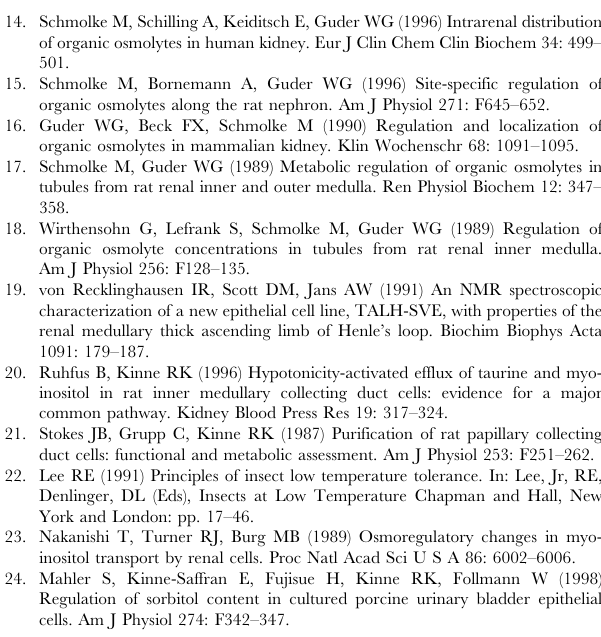
FIGURE S7. Effect of urea, sorbitol and their mixtures (at different ratios) on the proteins at pH 7.0; Table S1. Thermo- dynamic parameters associated with the thermal unfolding of RNase-A at different pH values in the presence and absence of